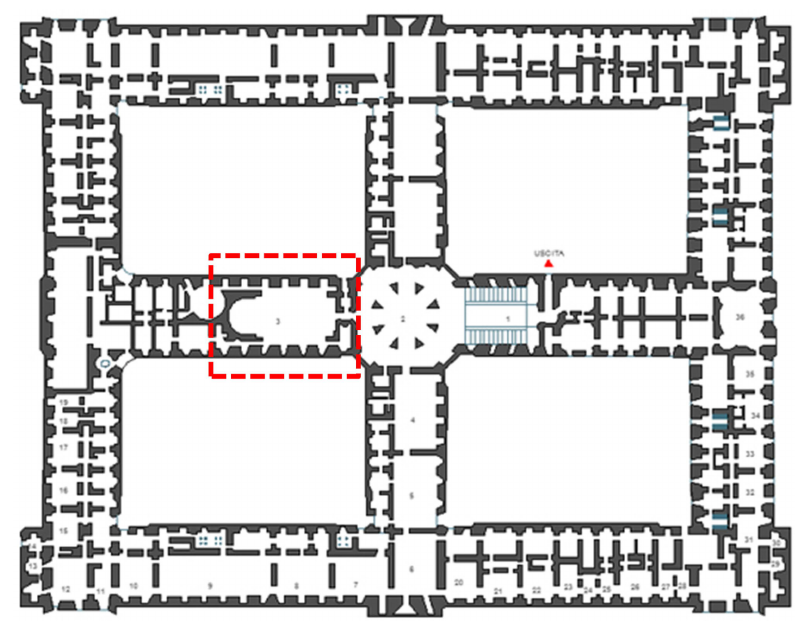
Figure 1. Plans of the Royal Palace in Caserta, showing the position of the Palatine Chapel.